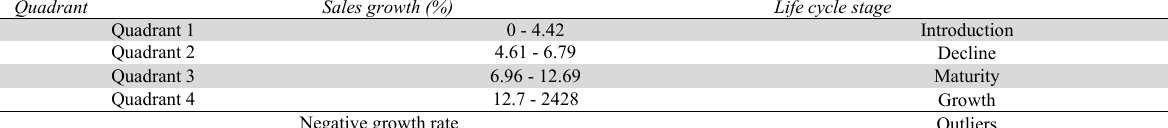
Firm categorization into life cycle stages